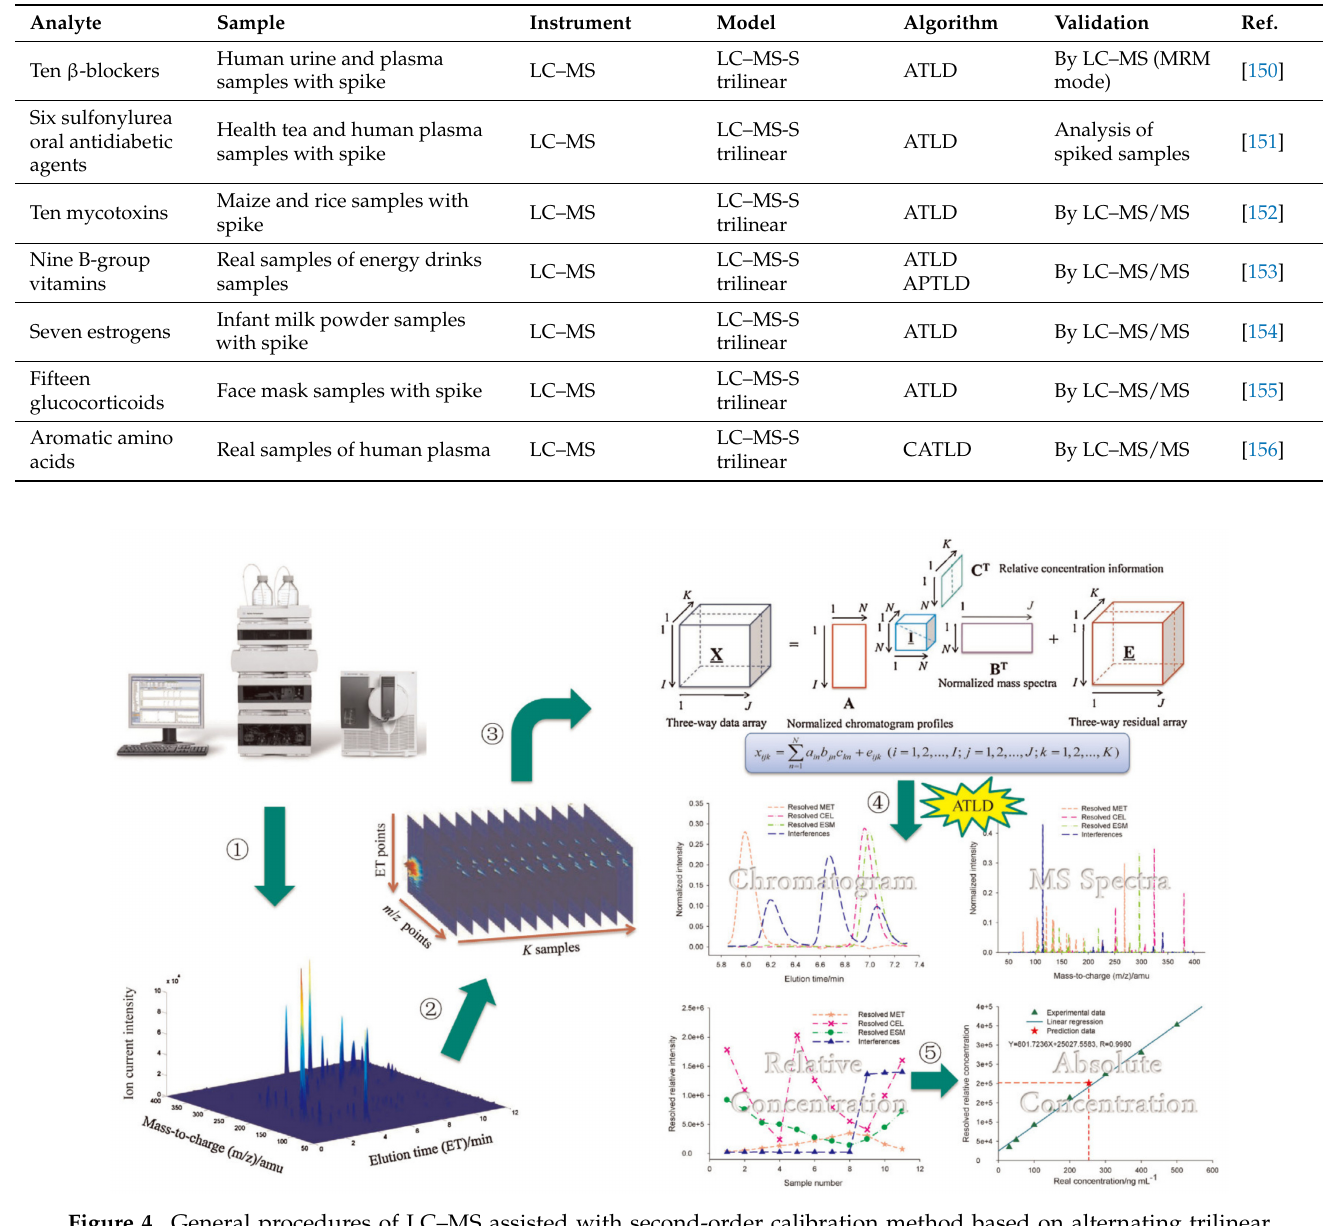
Figure 4. General procedures of LC–MS assisted with second-order calibration method based on alternating trilinear decomposition (ATLD) algorithm. 1 (cid:13) Generate a two-way matrix of responses of one sample by LC–MS in full scan